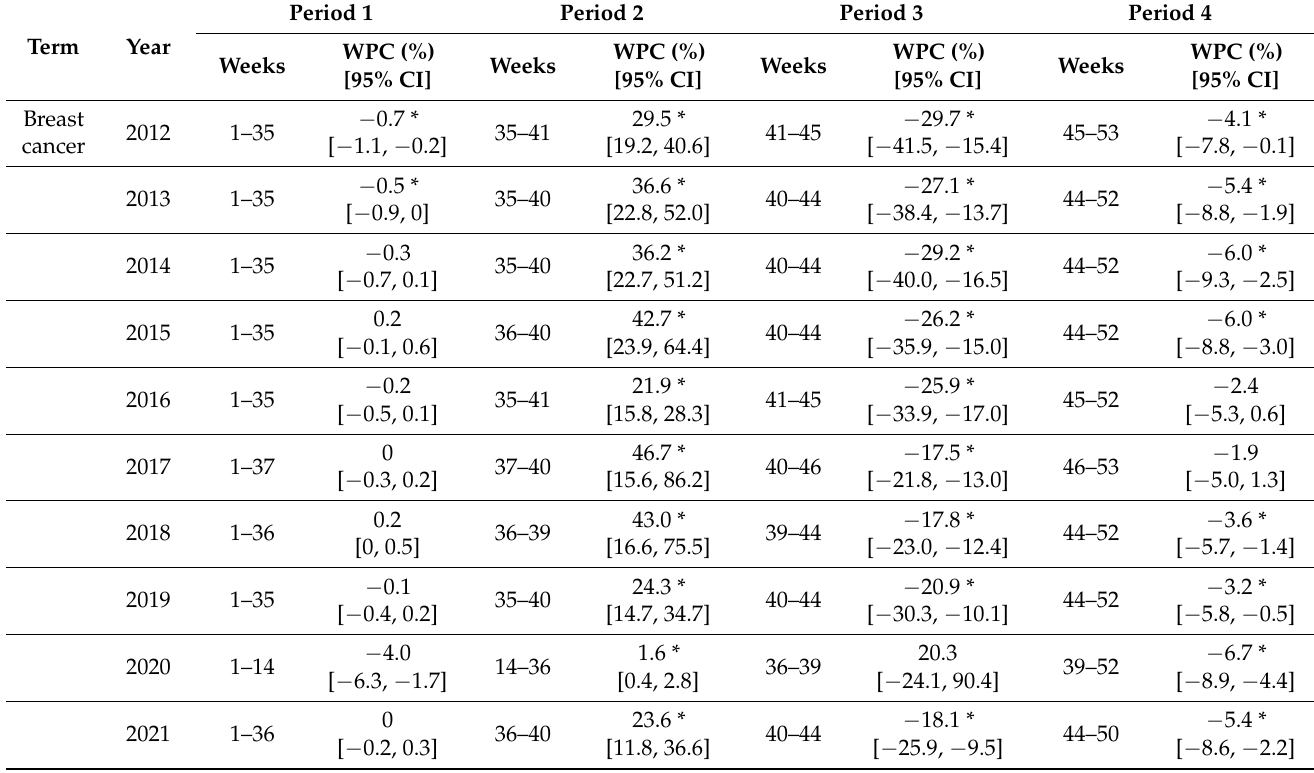
Table 1. Trend changes in relative search volumes of the term “Breast cancer” (2012–2021).